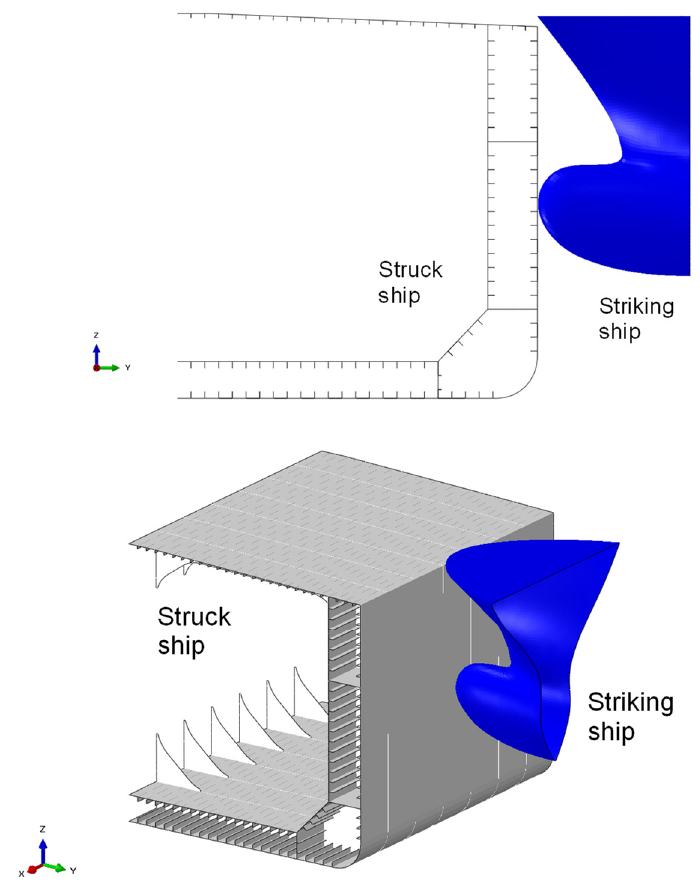
Figure 5. Considered collision scenario and modeling extents.